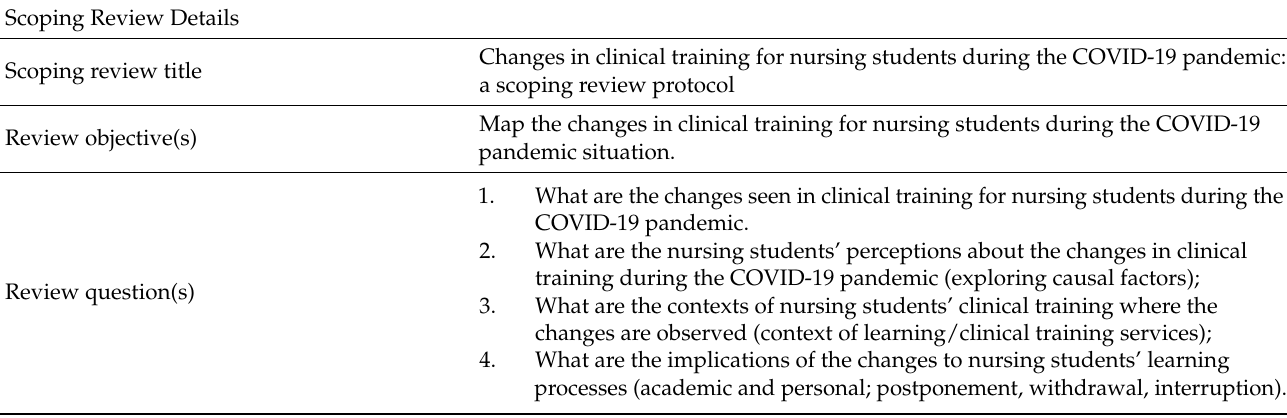
Table 2. Data extraction